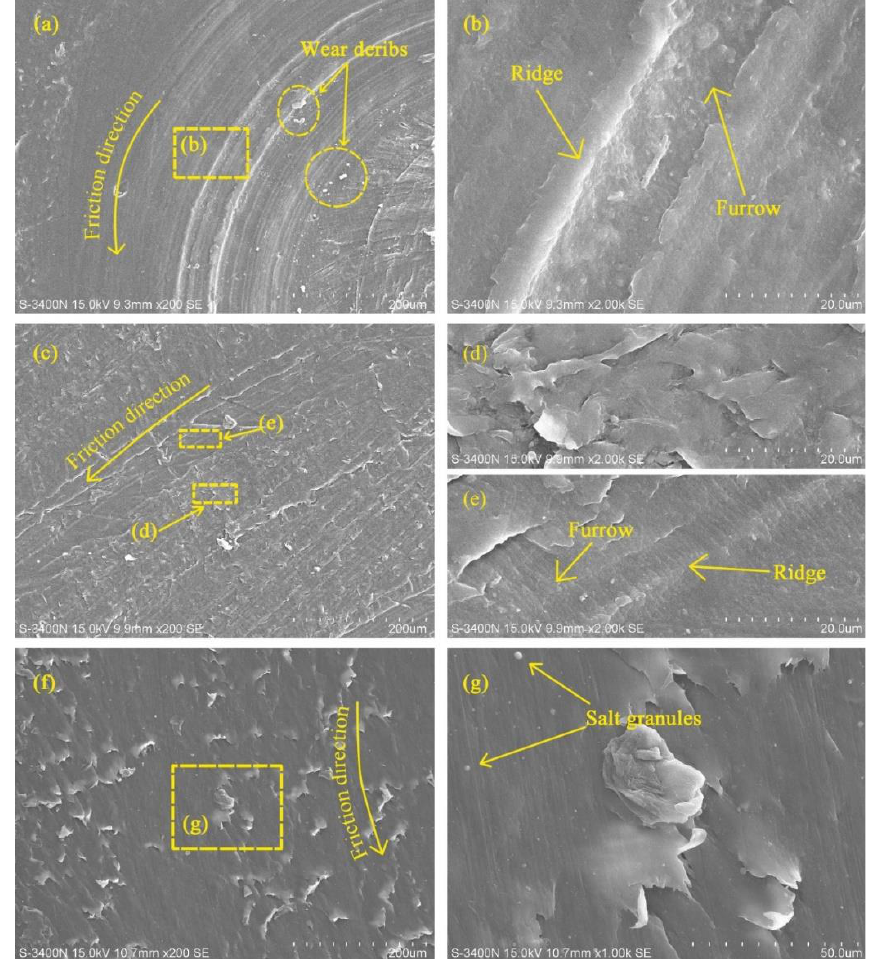
Figure 9. SEM micrographs of worn surfaces of UHMWPE at 1100 r/min speed ( a ) dry friction, ( c ) water-unsaturated lubrication and ( f ) brine-unsaturated lubrication; ( b , d – e , g ) are the images taken at the marked positions in the micrographs. Table 4. Temperatures of UHMWPE surface at 50 N load under different friction